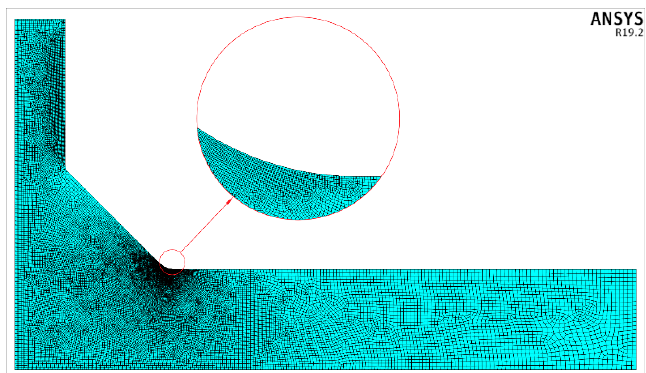
Figure 3. Example of a finite element mesh for θ = 45°, while X = 0.25, Y = 0.415, and T / t = 1.